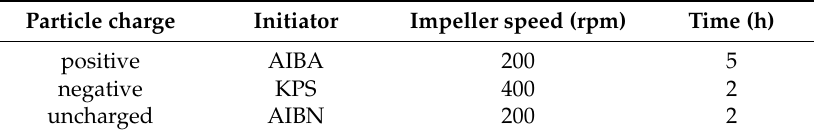
Table 1. Synthesis parameters for differently charged polystyrene (PS)